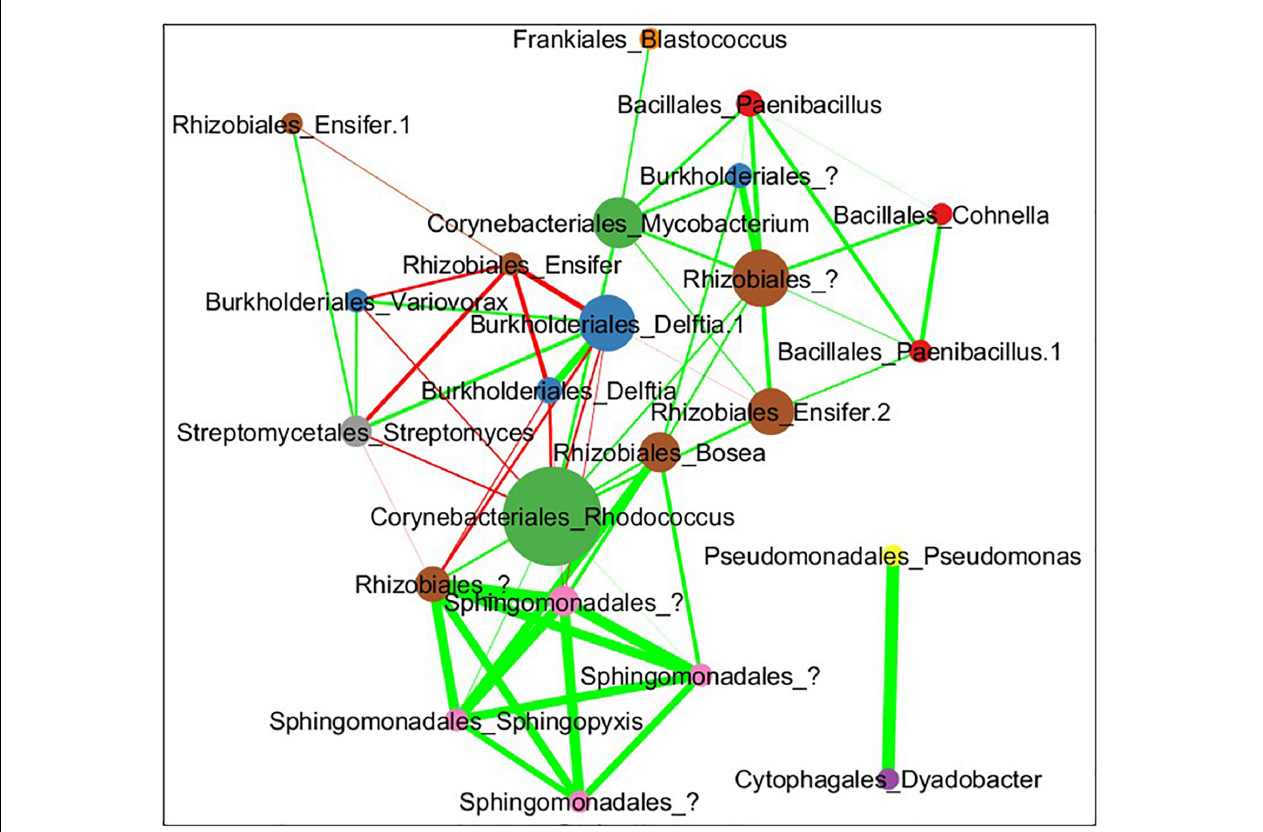
FIGURE 9 | Pearson correlation coefficient network of co-abundance data from MSC-1 in soil. Each circle represents a specific OTU with the name of the species shown as “Order”_“Genus.” These taxonomic levels were chosen because we now have a simple community represented in the network, allowing for more detailed taxonomies to be examined. Nodes are sized by their betweenness centrality in the network, those showing higher betweenness being larger. Lines indicate instances of high correlation coefficient, either > 0.35 (green lines) or < 0.35 (red lines) thickness of lines represents the strenght of the